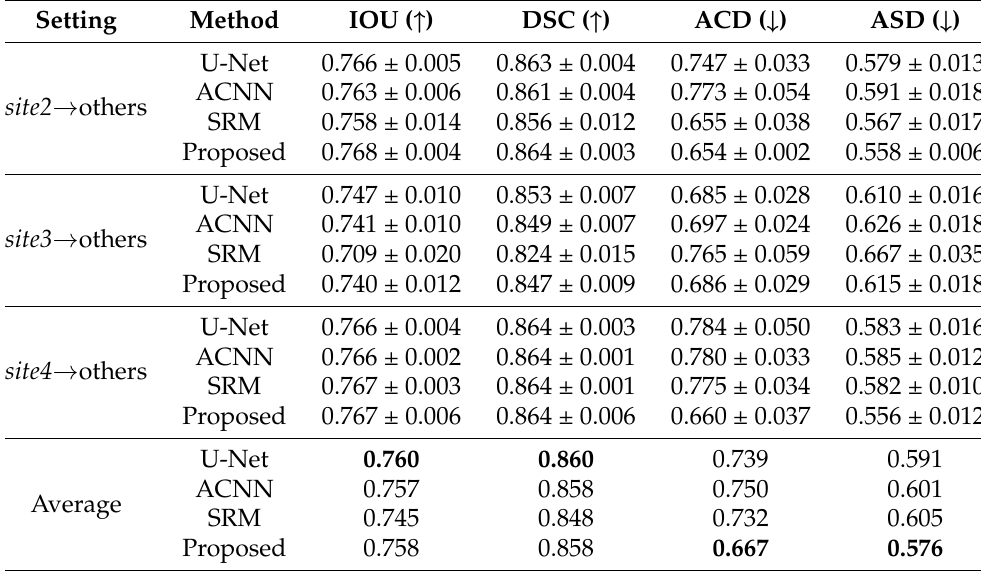
Table 7. Comparison of the domain robustness in the spinal cord segmentation task. The best result on averaging over three settings is shown in boldface.